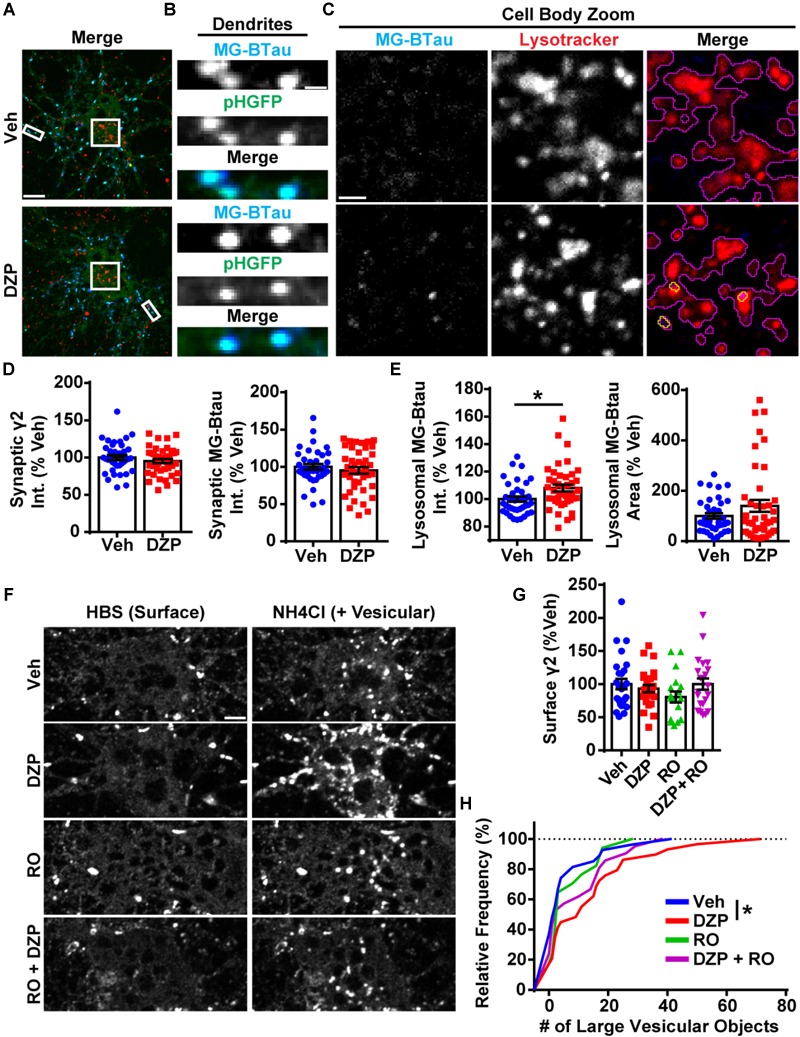
Lysosomal targeting and vesicular accumulation of γ2-GABAARs in response to DZP. (A) γ2pHFAP neurons were pretreated for 12–18 h with 1 μM DZP, then pulse-labeled with 100 nM MG-BTau dye for 2 min, and returned to conditioned media at 37°C ± DZP for 1 h. 50 nM Lysotracker dye was added at the 30 min mark to identify lysosomes. MG-BTau = blue; pHGFP = green; Lysotracker = red (n = 37–42 neurons; 5 independent cultures). (B) Dendrite zoom images show MG-BTau labeling at γ2pHFAP synapses. (C) Cell body zoom images highlighting colocalization of MG-BTau labeled GABAARs (yellow trace) at lysosomes (purple trace). (D) Dendrite pHGFP and MG-BTau measurements reveal surface synaptic γ2-GABAAR levels are not altered by DZP. (E) The pool of internalized MG-BTau GABAARs colocalized at lysosomes was enhanced in DZP treated neurons as measured by intensity (∗p ≤ 0.05, Student’s t-test; error bars ± s.e.m). (F) Neurons treated 20–28 h with vehicle or DZP. The DZP site antagonist Ro 15–1788 (5 μM) was added 1–2 h prior to imaging to inhibit DZP binding at GABAARs. Neurons were first imaged in HBS, and then perfused with NH4Cl (pH 7.4) to reveal intracellular γ2pHFAP receptors. DZP treated neurons accumulated more γ2-GABAARs in large vesicular structures compared to vehicle (n = 20–27 neurons; 3–4 independent cultures). (G) Surface intensity of γ2pHFAP was not different between treatments (one-way ANOVA; error bars ± s.e.m). (H) DZP-treated neurons more frequently demonstrated accumulation of γ2pHFAP in large vesicles (∗p ≤ 0.05 Kolmogorov–Smirnov statistical test). Int., fluorescence intensity. Scale bars in μm: (A) = 10; (B) = 1; (C) = 2, (F) = 5.